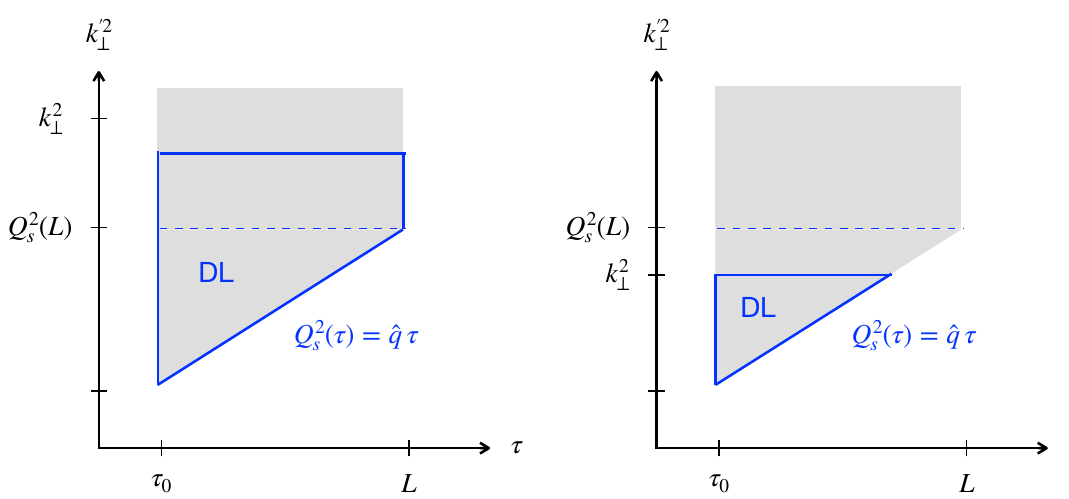
Figure 3. The double logarithmic phase space for gluons fluctuations with lifetime τ and transverse momentum k 0 in the dilute (left) and dense (right) regimes. The choice between these two regimes ⊥ depends on the final momentum k ⊥ of the double logarithmic cascade. For the TMB distribution, we set k ⊥ = 1 /x ⊥ where x ⊥ is the initial effective dipole size. In this sketch, we have simplified the = ˆ q 0 τ saturation line k 2 = Q 2 ( τ ) by its tree-level form k 2 s ⊥ ⊥